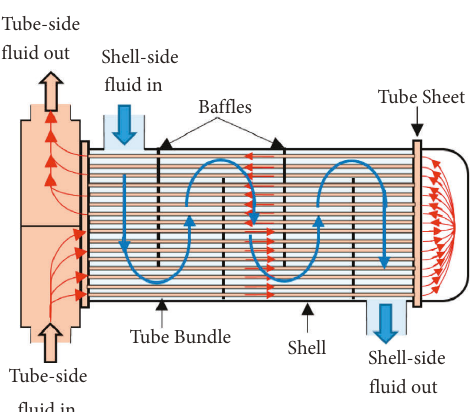
Figure 6: Illustration of shell and tube heat exchanger diagram